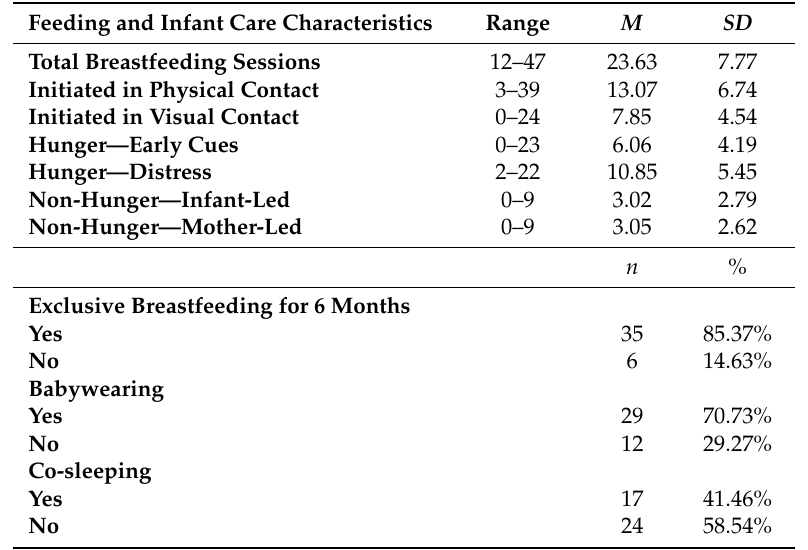
Table 5. Descriptive statistics for Study